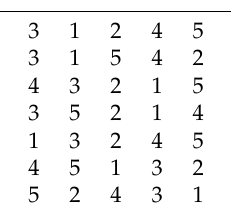
Figure 5. Latin Hypercube Sampling (LHS). Each of L = 7 parameters takes the values from its N = 5 sampling points. The rows are random permutations of the numbers 1 to 5, while the columns are the parameter vectors on which the simulations will be